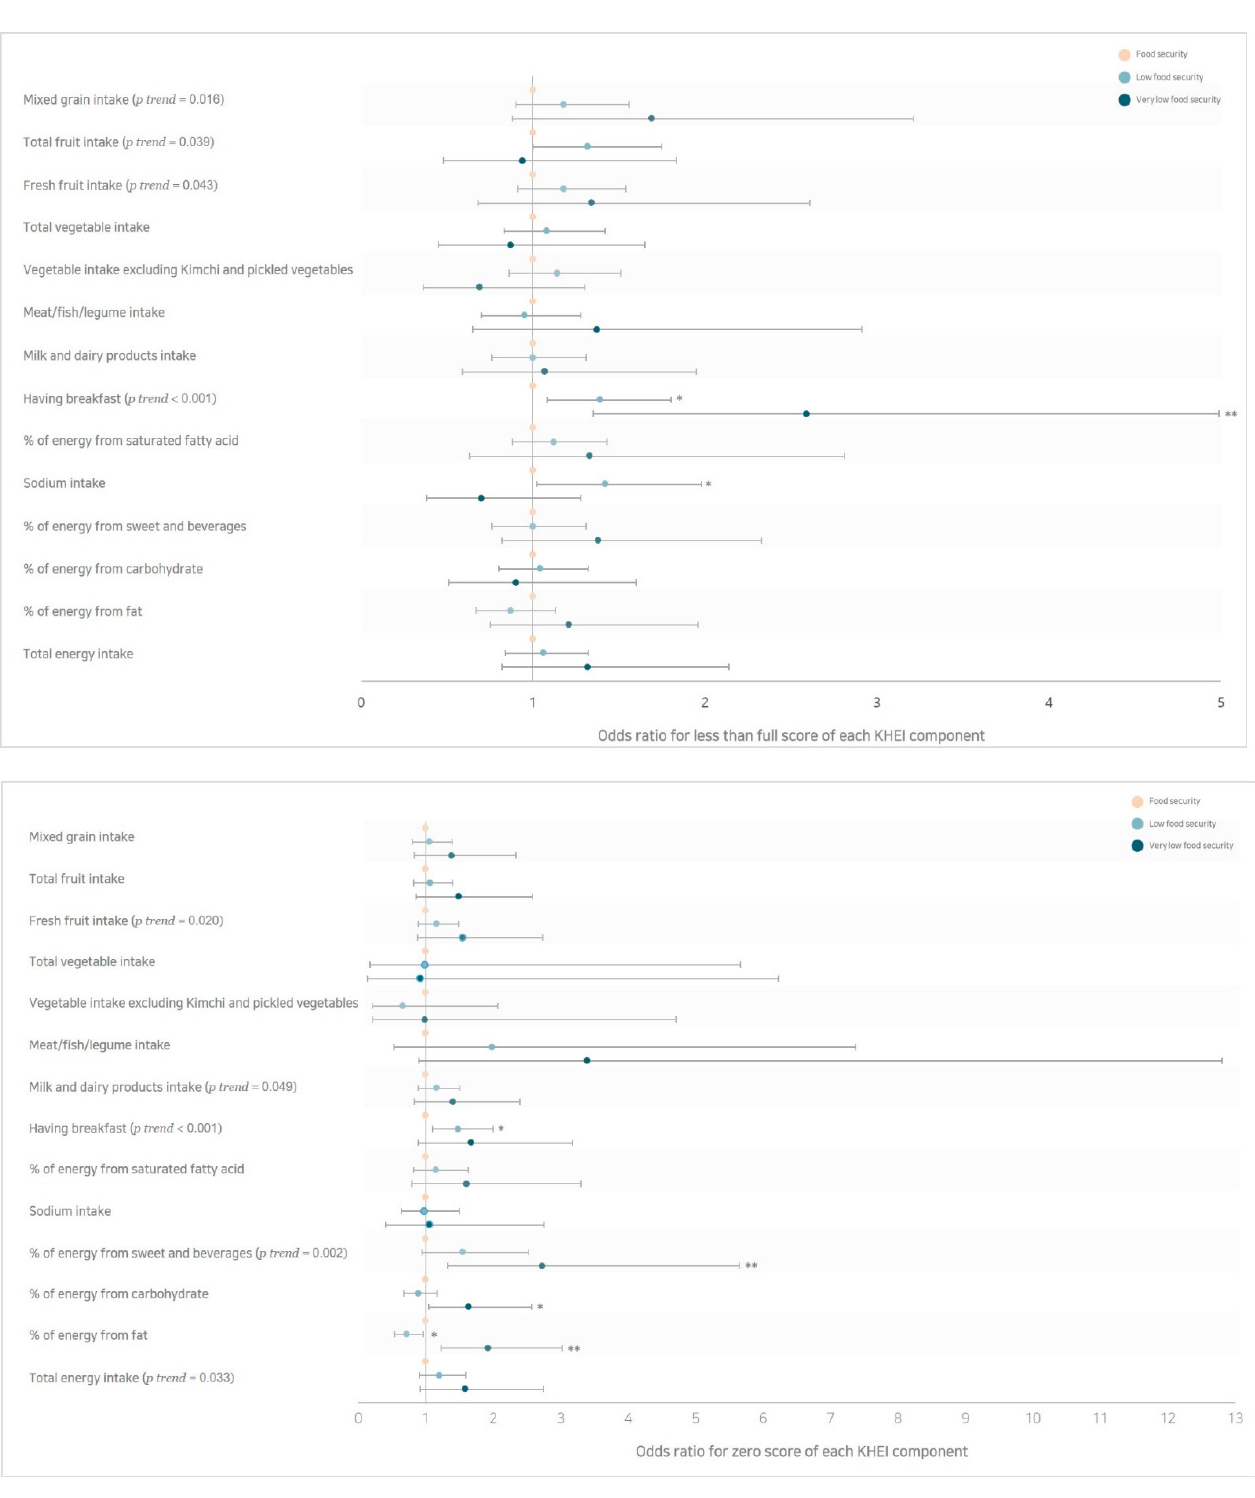
Figure 1. The risk of less than full scores and zero scores according to household food security status. Results based on Model 3 in Table 4 adjusted for age, sex, survey year, total energy intake, household size, education, marital status, household income level, physical activity level. * p < 0.05, ** p < 0.01. Abbreviations: KHEI, Korean Healthy Eating Index.